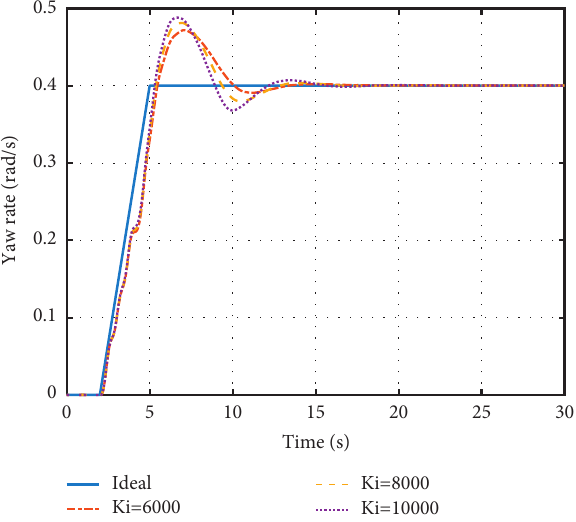
Figure 11: Yaw rate variation with different K